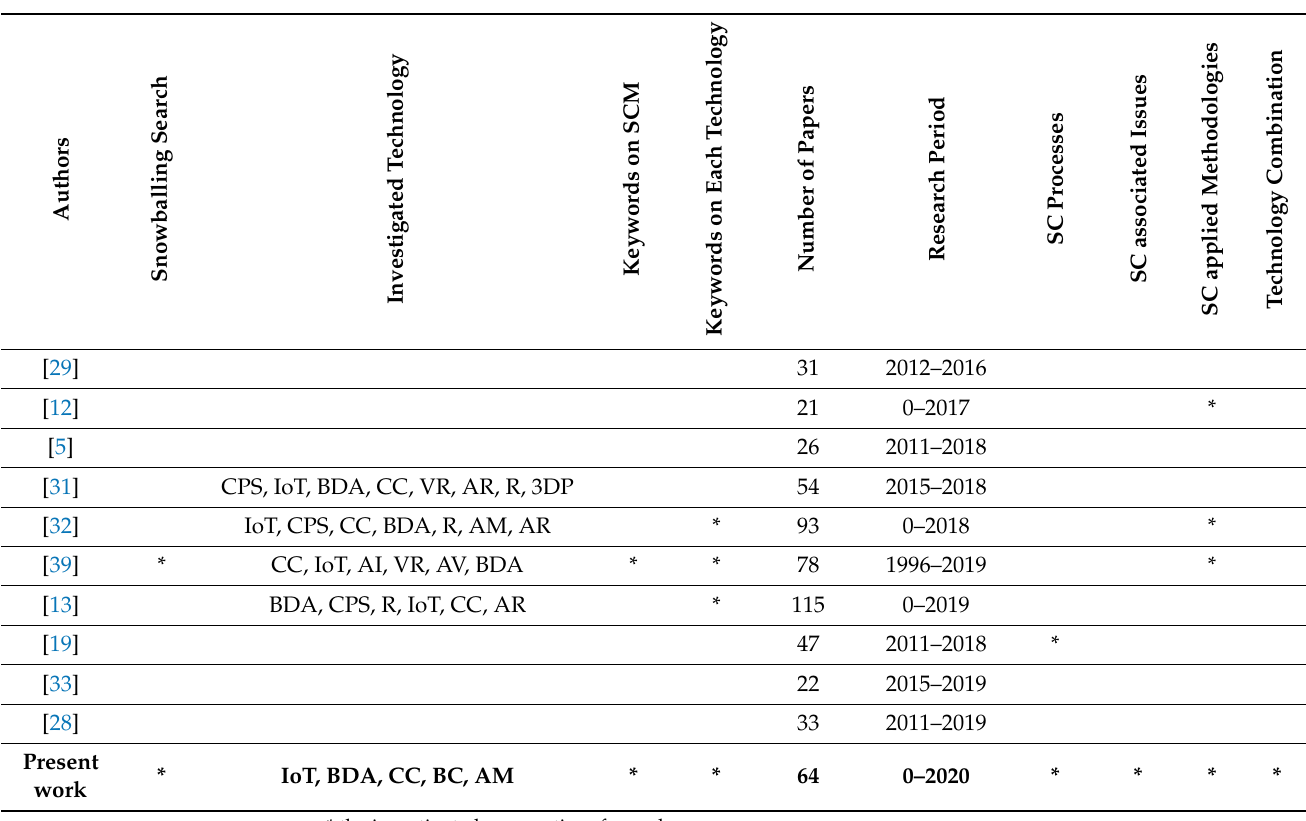
Table 2. Summary of the previous works.